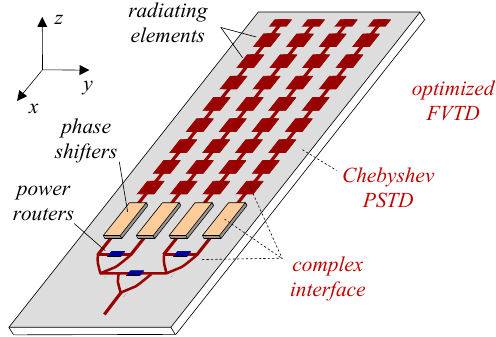
Figure 12: Geometry of a reconfigurable MEMS-controlled antenna on a double-negative metamaterial substrate. Model- ing regions: complex-interface schemes for the radiating ele- ments and the routers, optimized FVTD technique for the open region, and PSTD algorithm for the